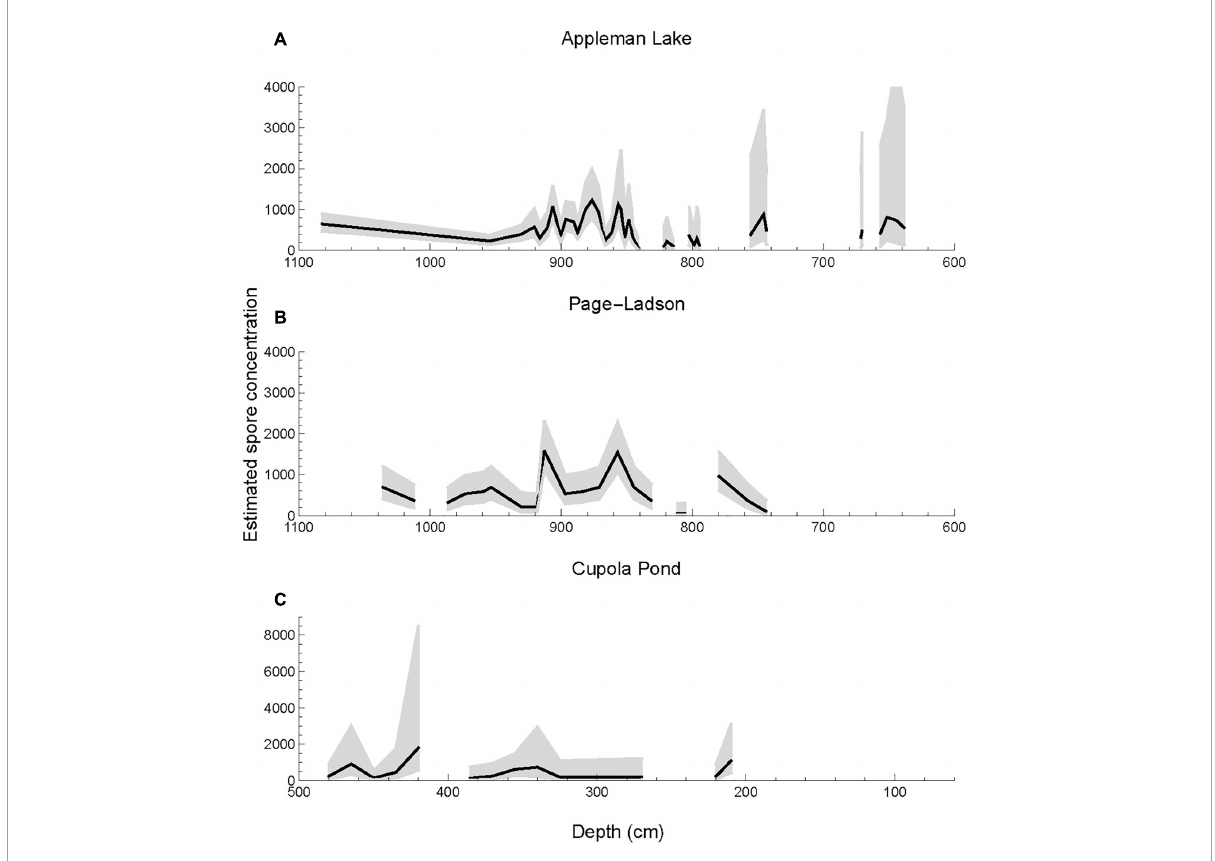
FIGURE5 Estimated spore concentration (black) and 95% confidence interval (gray shading) for a single coprophilous (dung-inhabiting) fungal spores (CFS) taxon ( Sporormiella-Preussia complex) data from (A) Appleman Lake, Indiana (Gill et al., 2009), (B) Page-Ladson, FL (Halligan et al., 2016), and (C) Cupola Pond, MO (Perrotti et al.,